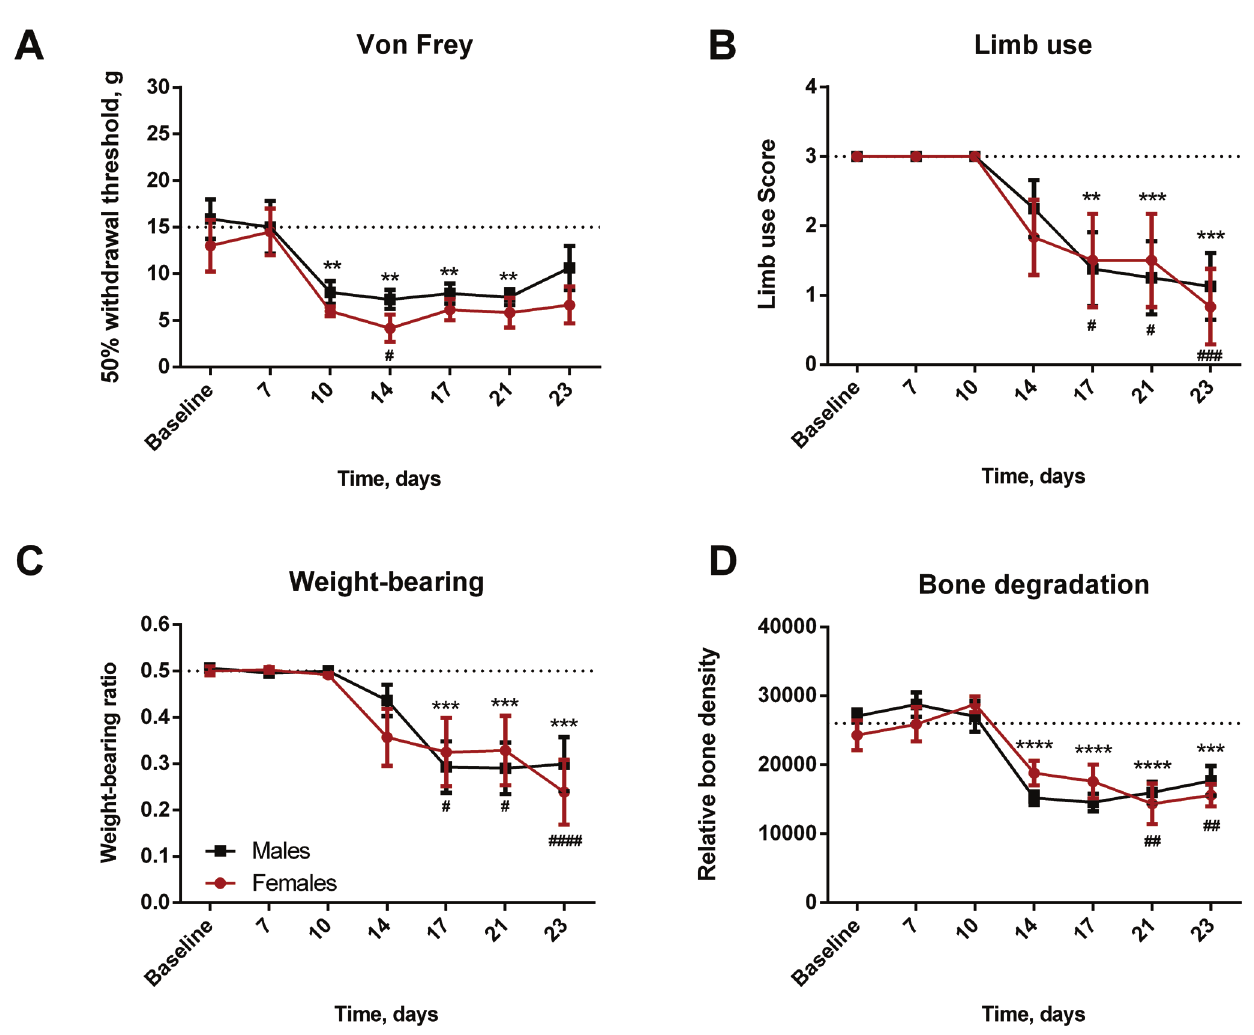
Figure 7. Pain-related behavior and relative bone density in animals with a consistent bioluminescence signal throughout the experiment. ( A , B and C ) Both females and males demonstrate significant decreases in 50% withdrawal threshold, limb use score and weight-bearing ration. ( D ) Both sexes show a similar extent of bone degradation. ** / *** / **** =males compared to baseline, #/##/#### =females compared to